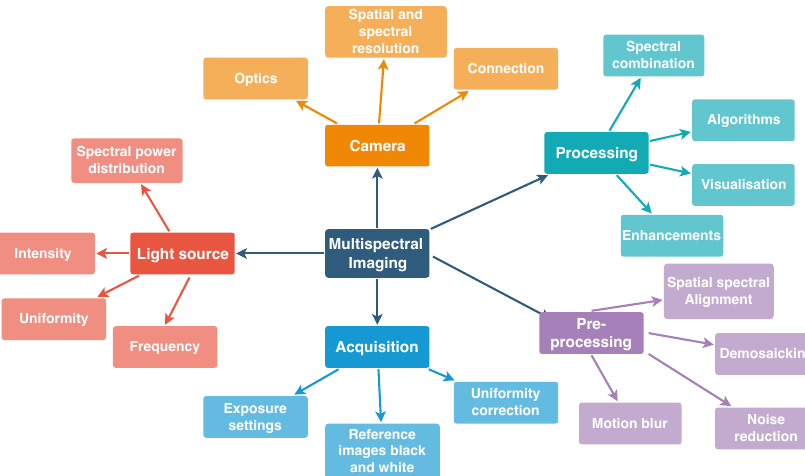
Figure 1. Overview of key aspects for generic spectral image acquisition including the camera, light source, acquisition, pre-processing steps and processing steps for the spectral image. For SFA imaging temporal aspects are of special importance: the flicker frequency of the light source and the connection speed to the camera. All of the items shown in this diagram have to be addressed for successful spectral image acquisition and meaningful data processing. Table 1. Overview of spectral imaging techniques including RGB [33], filter wheel cameras (FW),